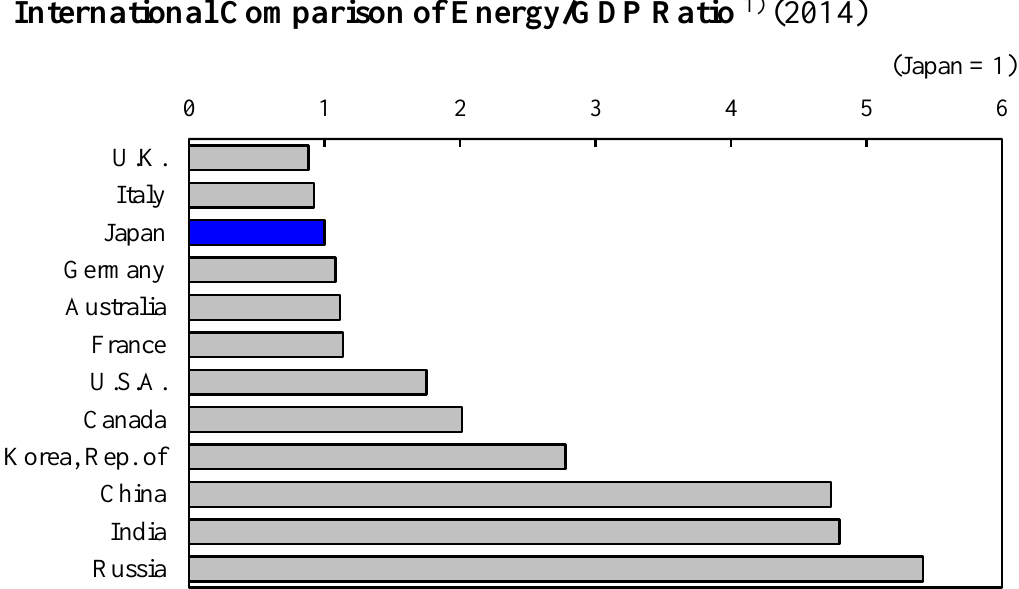
Figure 7.2 International Comparison of Energy/GDP Ratio 1)